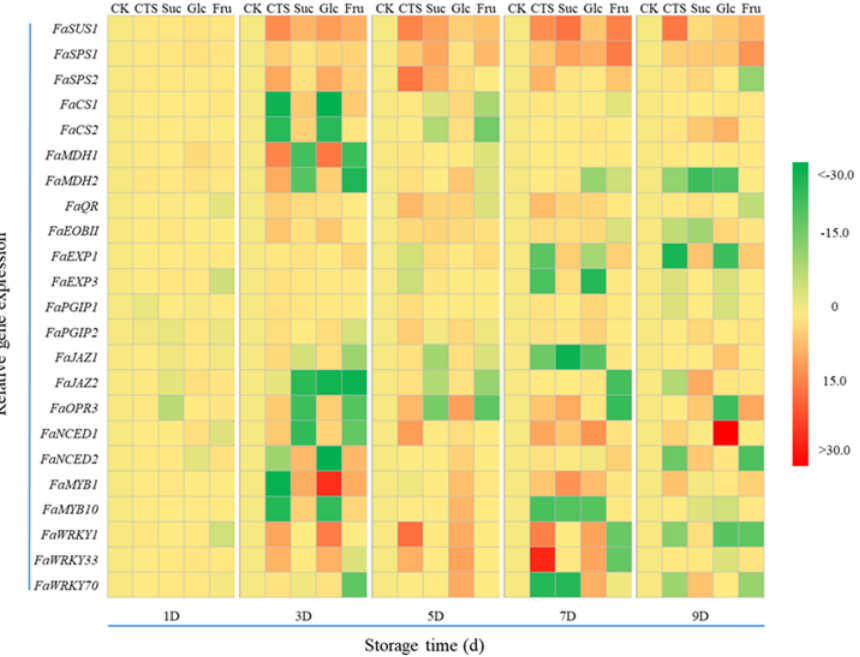
Figure 8. Effects of chitosan (3 g/L), sucrose (5 g/L), glucose (15 g/L), and fructose (15 g/L) on transcription of genes related to fruit quality and disease resistance. The fruit treated with distilled water was used as the control (CK), relative gene expressions in strawberries treated with 3 g/L chitosan, 5 g/L sucrose, 15 g/L glucose, and 15 g/L fructose were calculated. The expressions in the chitosan, sucrose, glucose, and fructose groups were then each divided by that in the control, and the results were used to create a heat map. CTS, chitosan; Suc, sucrose; Glc, glucose; Fru, fructose.